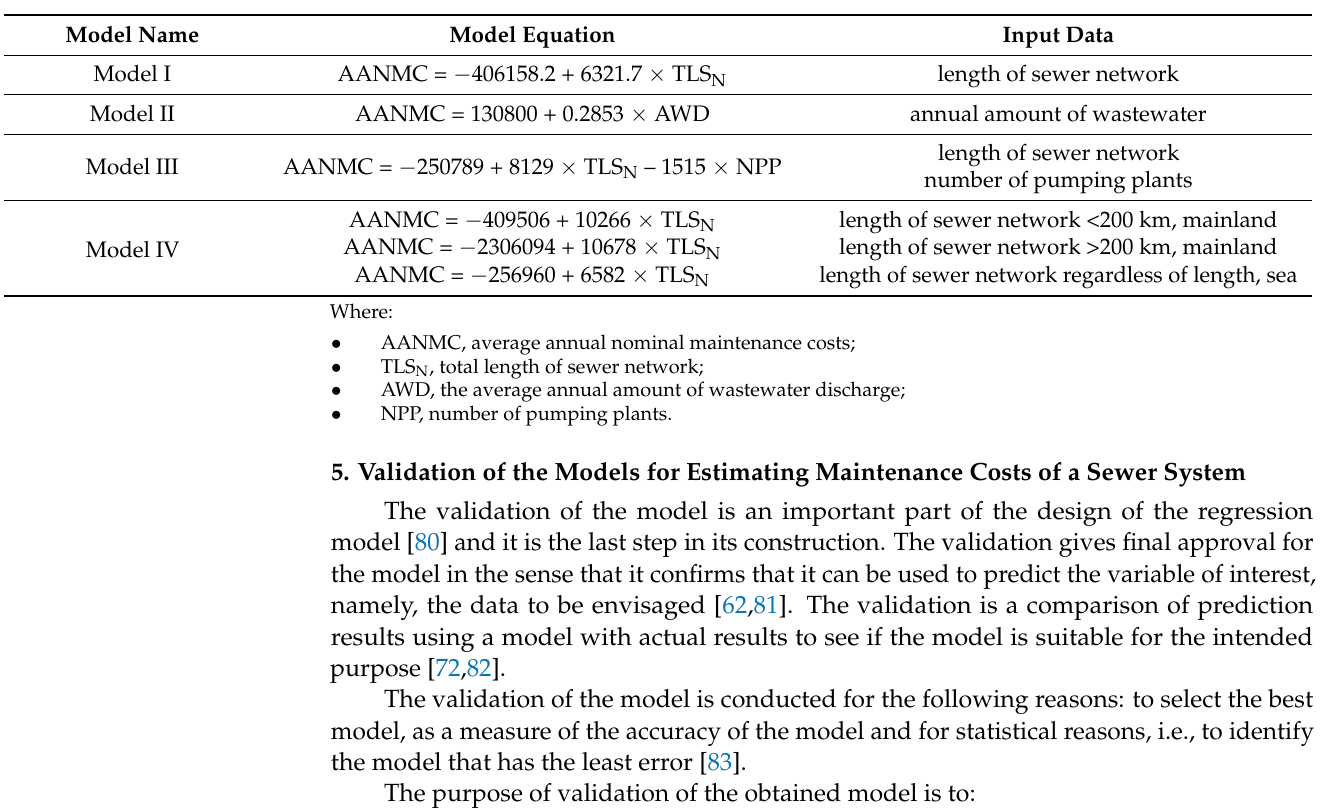
Table 13. Summary overview of developed